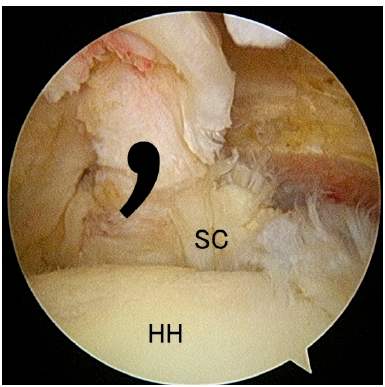
Figure 1. Subscapularistearinthert. shoulder. Asthesuperiorglenohumeralligamentandcoracohumeral